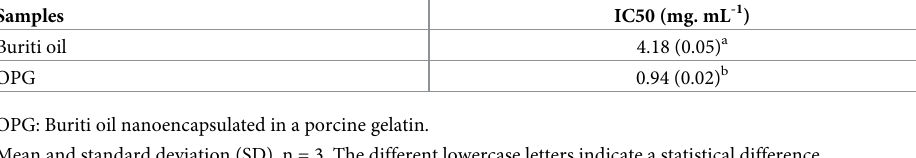
Table 4. Antioxidant activity (IC 50) buriti oil and OPG. Samples